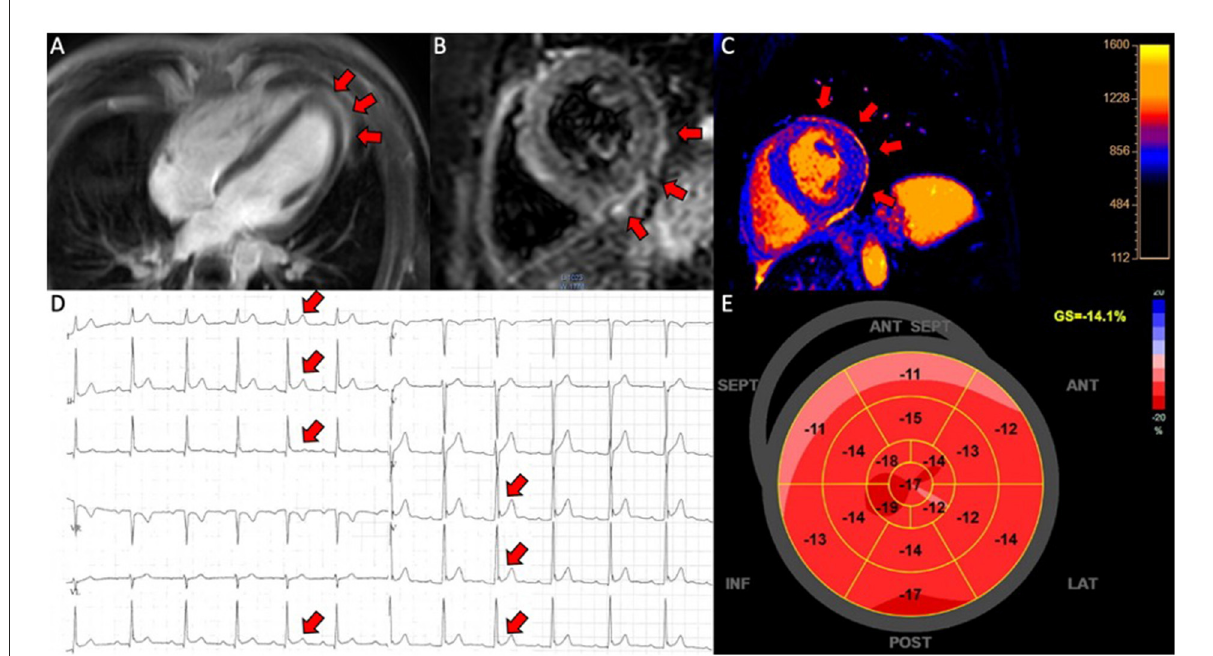
FIGURE2 Pericarditis in a patient (case 9). (A) CMR, late gadolinium enhancement in the pericardium in 4-chamber view; (B) CMR, short axis T2-weigthed image showing hyper-intensive signal in the pericardium indicative of oedema; (C) CMR, T1-map in short axis showing increased T1 values up to 1,231ms in the pericardium; (D) electrocardiogram showing ST-elevations in lead I, II, III, aVF and V4-V6; (E) 17-segment plot of global longitudinal strain on echocardiography with decreased values in the basal segments anteriorly.